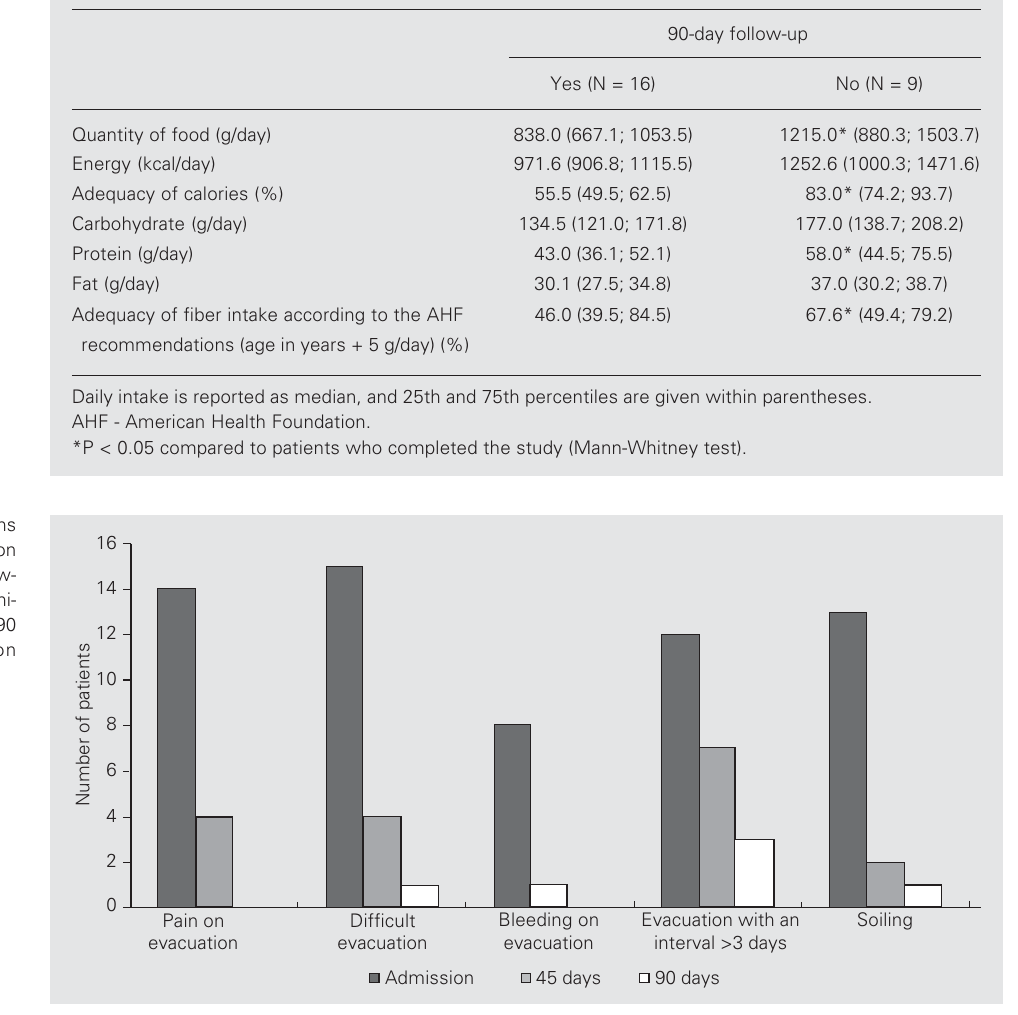
Table 2. Dietary data at admission of patients who completed or did not complete the